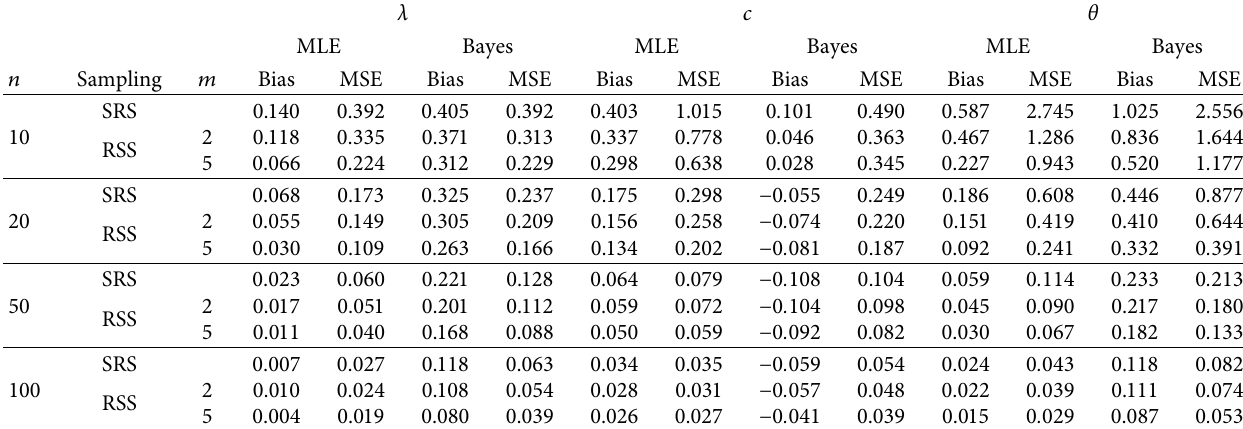
Figure 1: Shapes of the probability density function of GG distribution for different parameter values. Table 1: Bias and MSE of the MLE and Bayes estimates under RSS and SRS for different sample sizes and different set sizes when λ � 0 . 5, c � 0 . 5, and θ � 1 . 0.